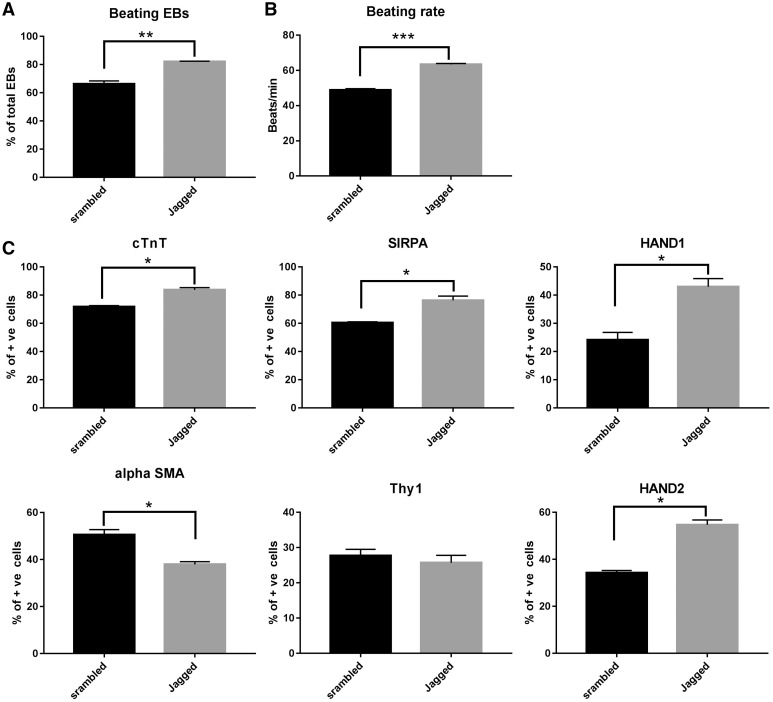
Activation of NOTCH signalling pathway restores the ability of HLHS- iPSC lines to give rise to cardiomyocytes. (A) Analysis of the percentage of EBs that generate contraction during differentiation of Jagged and scrambled peptide treated HLHS-iPSC line; (B) Analysis of beating frequency of EBs that generate contraction during differentiation of Jagged and scrambled peptide treated HLHS-iPSC line; (C) Flow cytometry data analysis demonstrating that Jagged treatment enhances the ability of HLHS-iPSC to give rise to cardiomyocytes and reduces the ability to differentiate to smooth muscle cells when compared to scrambled peptide treated control cells at day 14 of the differentiation time-course. T-test analysis was carried out, ***P < 0.001; **P value between 0.001 and 0.01; *P value between 0.01 and 0.05. Data are presented as mean+/- SEM, n = 3+.